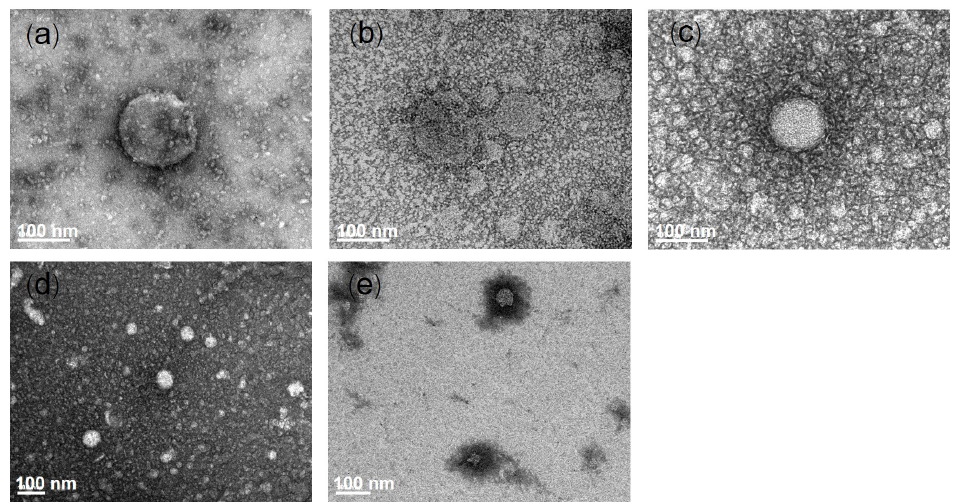
Figure 1. Transmission electron microscopy images of different rosmarinic acid-loaded liposomes: ( a ) Conventional liposomes (CL), ( b ) ultradeformable liposomes (ULs), ( c ) ULs with oleic acid, ( d )